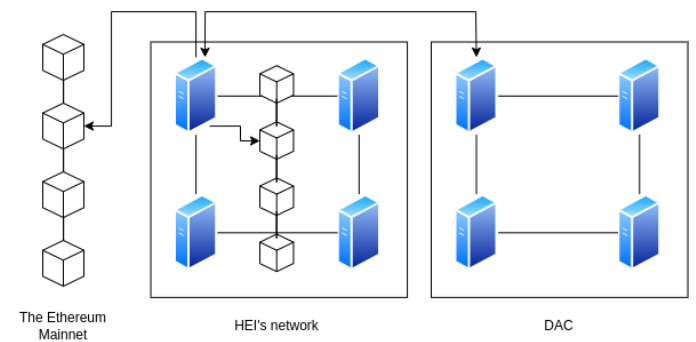
Figure 5. The connections in the